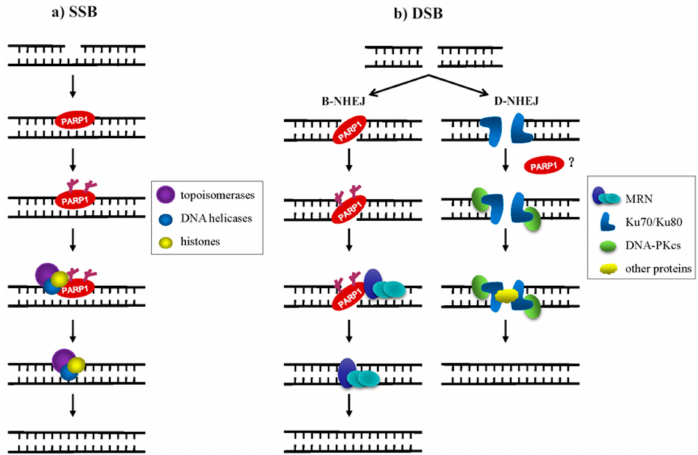
Figure 3. Role of PARP1 in DNA damage repair. ( a ) Ionizing radiation (IR) or reactive oxygen species (ROS) induces cell SSBs. PARP1 recognizes the DNA break site and recruits topoisomerase, DNA helicases, and histones to complete SSBR; ( b ) in the PARP1-dependent B-NHEJ pathway, PARP1 is thought to recognize and bind to the DSB site and once activated, recruits the MRN complex to DSB and completes the DNA repair (left). Whether PARP1 directly participates in D-NHEJ remains disputable